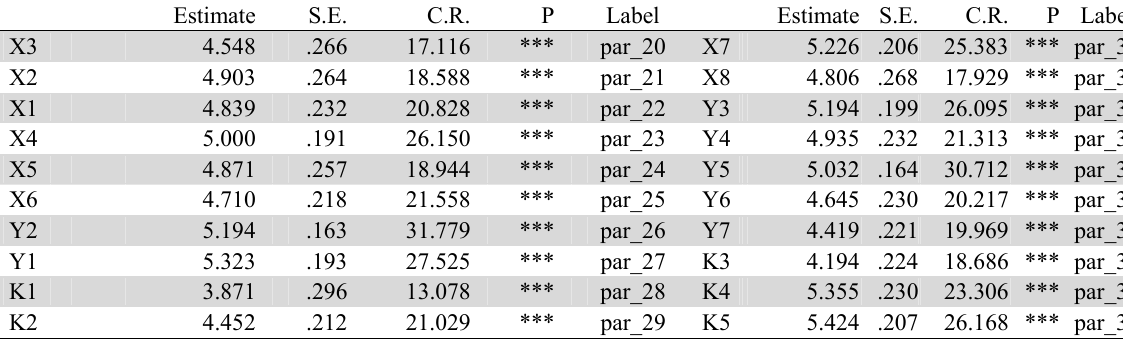
Intercepts: (Group number 1 - Default